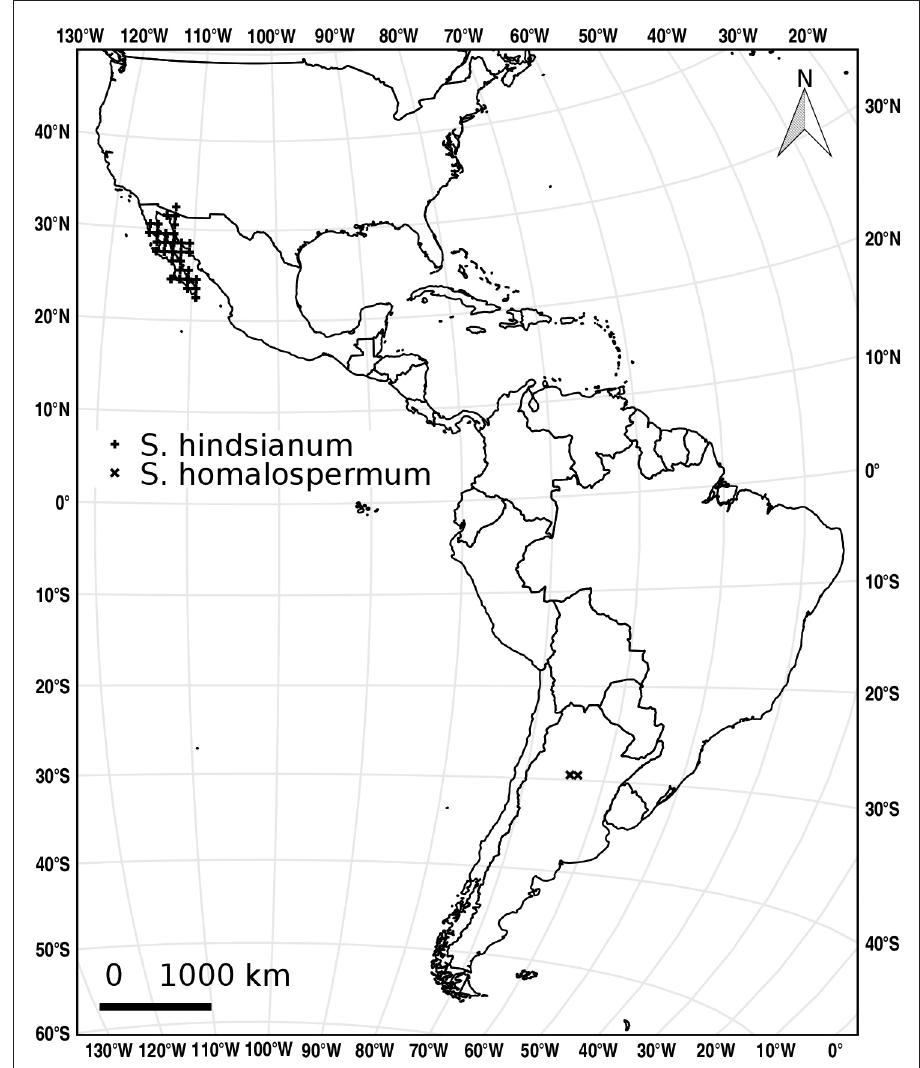
Figure 8. Distribution of S. hindsianum and S. homalospermum .